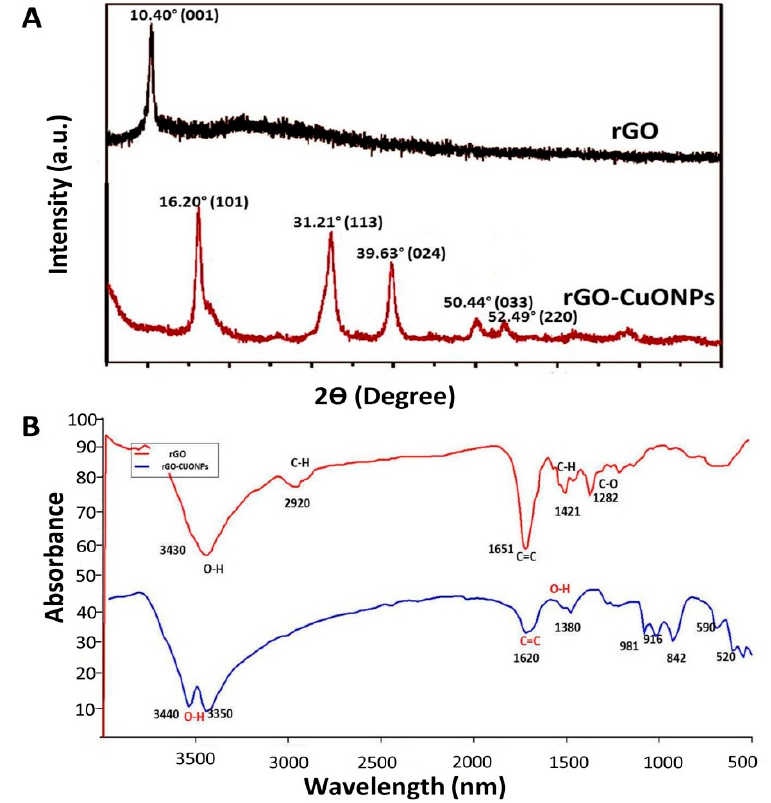
Figure 2. Characterization of rGO-CuO NPs. ( A ) XRD patterns and ( B ) FT-IR spectra of rGO and rGO-CuO NPs, as indicated.